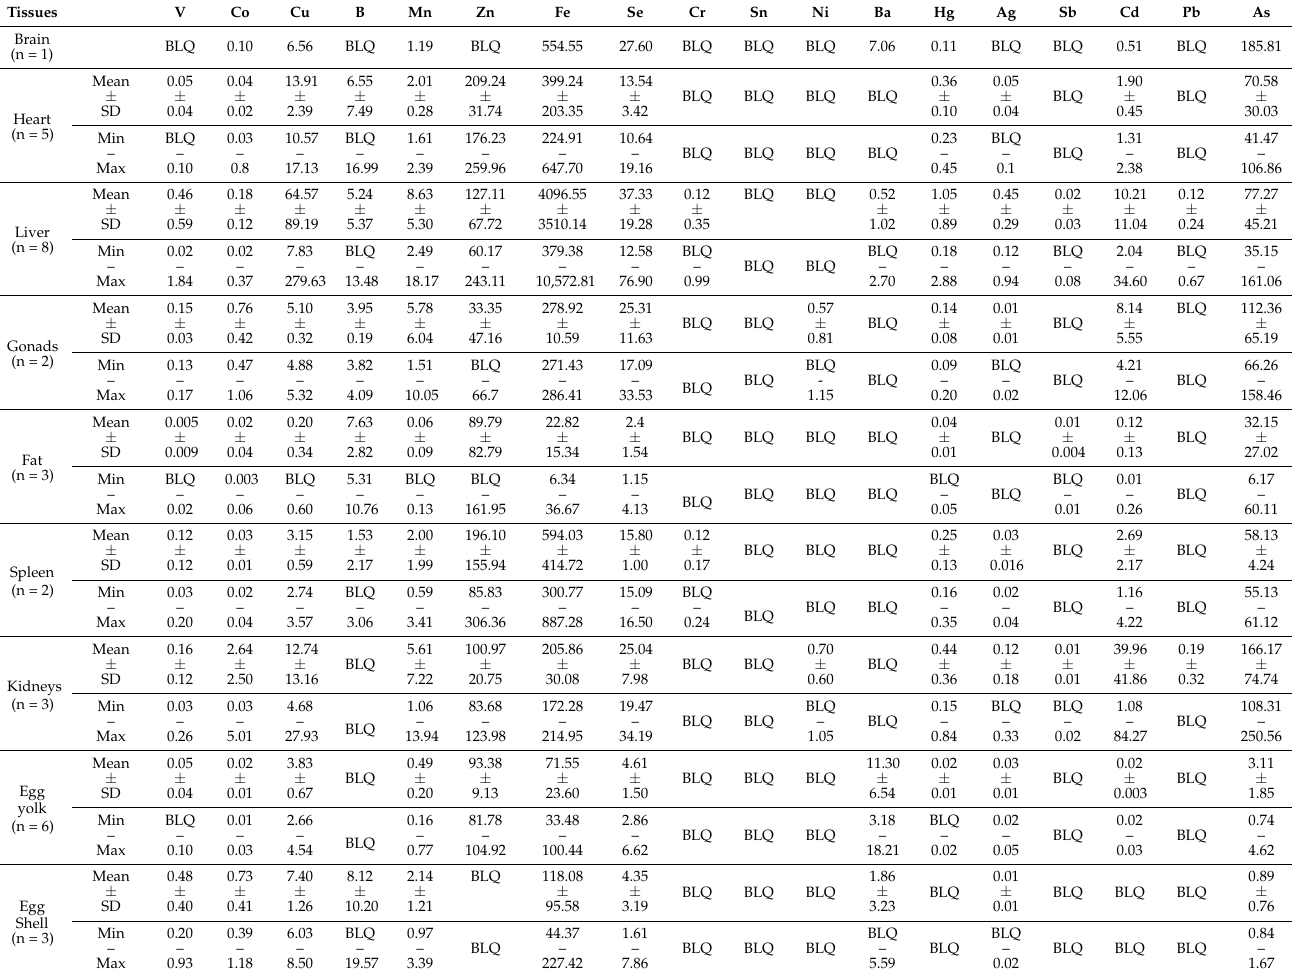
Table 1. Mean concentration ( µ g/g d.w.) ± SD and concentration range (minimum and maximum) measured for each tissue and element analysed. BLQ = below quantification limit: